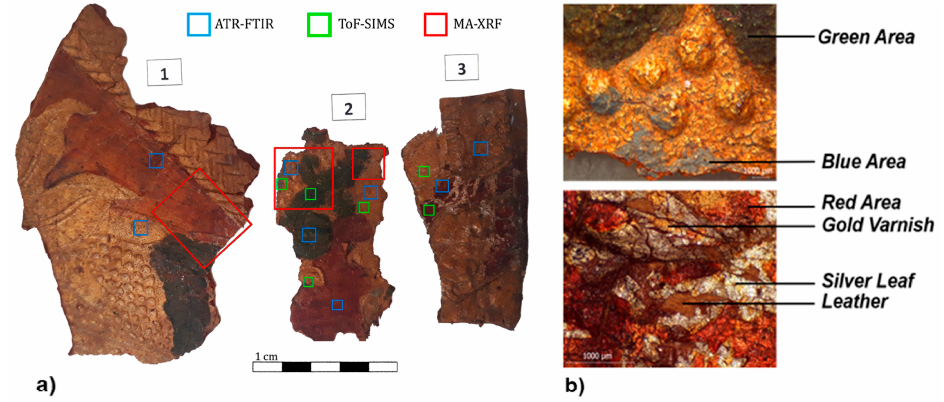
Figure 1. Fragments of gilt and painted leather ( a ) and details and description of the constitutive materials ( b ).